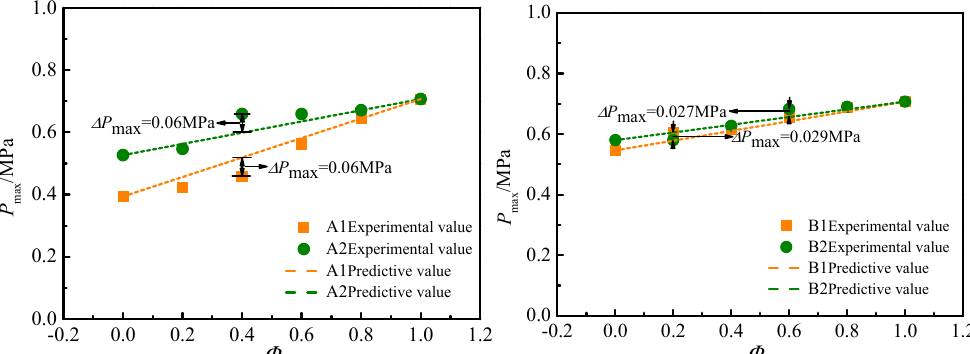
Figure 8. Comparison diagram of maximum explosion pressure prediction model and experimental results for hybrid mixtures.